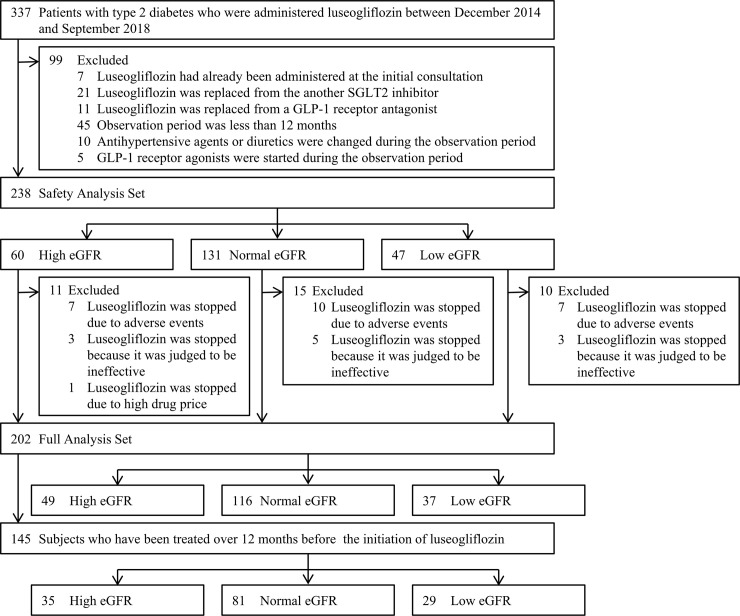
Flowchart of patient selection.The safety of luseogliflozin was analyzed in the safety analysis set (n = 238) and the effectiveness was investigated in the full analysis set (n = 202). The analysis sets were divided to high (≥90 mL/min/1.73 m2), normal (60 to <90 mL/min/1.73 m2) and low (<60 mL/min/1.73 m2) eGFR groups. SGLT2, Sodium-glucose cotransporter 2; GLP-1, glucagon-like peptide-1; eGFR, estimated glomerular filtration rate.